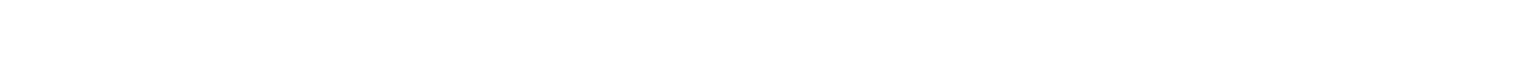
Figure 5. Overview of the new bamboo products value chain in Nongboua village.